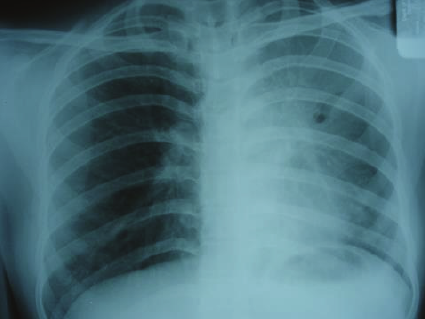
Figure 1: Chest radiograph of a young female showing collapse consolidation of left upper lobe caused by EBTB.